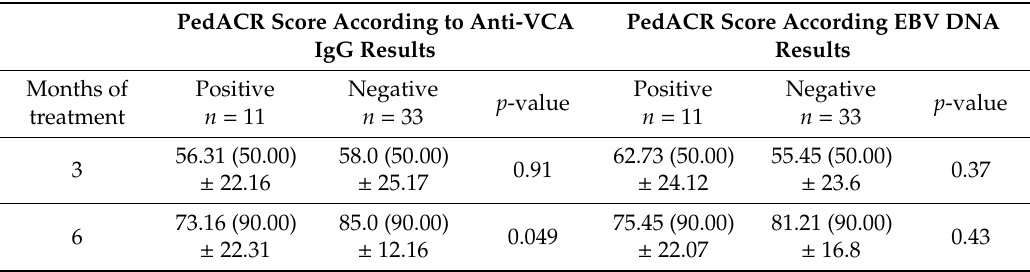
Table 8. Comparison of the response to treatment (PedACR) in JIA patients according to anti-VCA IgG concentration (positive > 1.1 vs. negative ≤ 1.1 U / mL) and EBV DNA results after 3 and 6 months of treatment. Results are presented as mean (median) ± standard deviation.